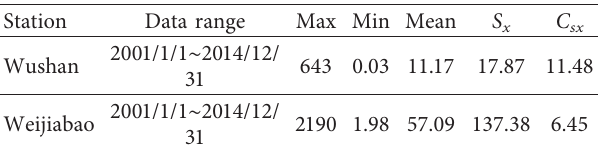
Figure 3: The observed daily runoff for the Weijiabao Hydrological Station from 2001 to 2014. Table 1: The characteristic parameters of daily streamflow at the Wushan and Weijiabao hydrological station (m 3